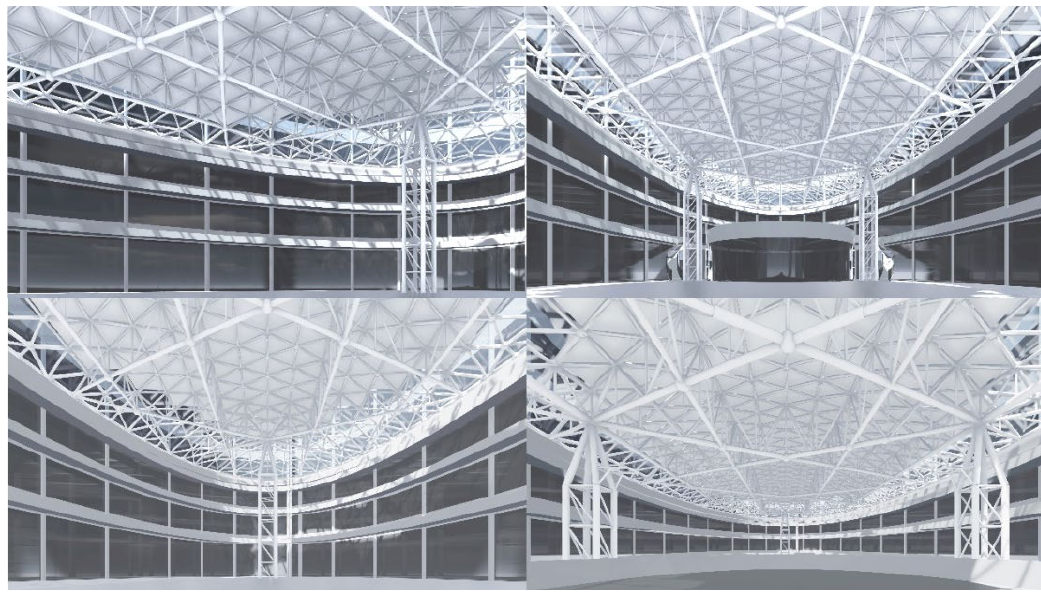
Figure 8. Conventional truss structure.